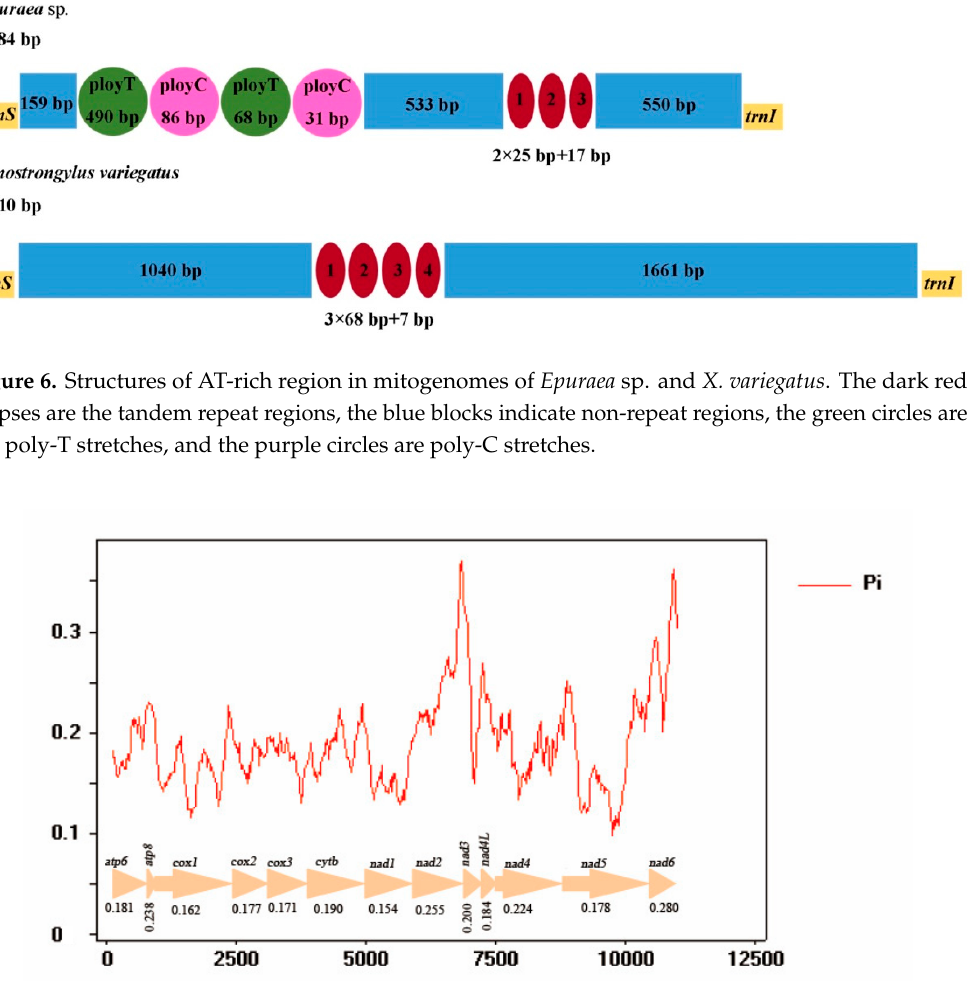
Figure 7. Sliding window analyses of 13 PCGs among seven nitidulid mitogenomes. The red line shows the value of nucleotide diversity (Pi) in a sliding window analysis (a sliding window of 200 bp with the step size of 20 bp); the Pi value of each gene is shown under the gene name.